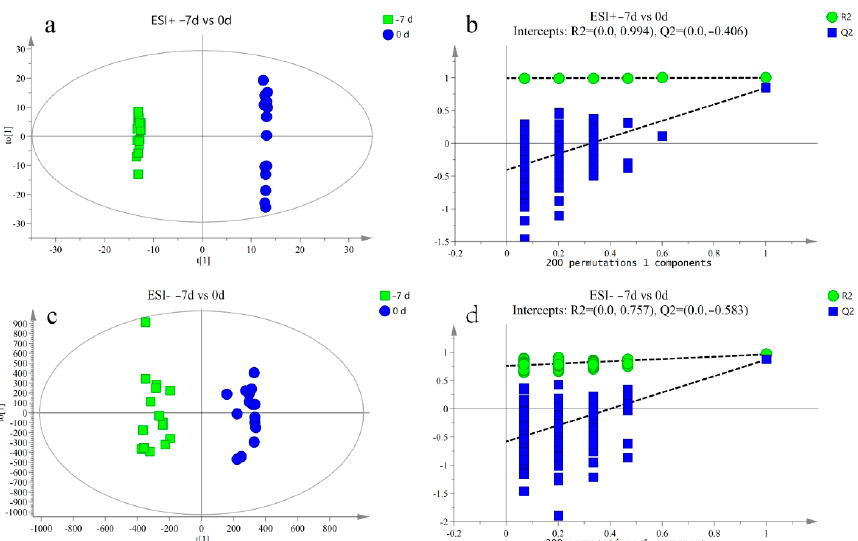
Figure 3. ( a , b ) Orthogonal partial least squares discriminant analysis (OPLS-DA) of scores and per- mutation test plots for the − 7 d and 0 d group samples analyzed in the positive ion mode, respec- tively. ( c , d ) Orthogonal partial least squares discriminant analysis of scores and permutation test plots for the − 7 d and 0 d group samples analyzed in the negative ion mode, respectively. t[1]—first principal component; to [1]—second orthogonal component. The intercept limit of Q 2 , calculated by regression line, is the plot of Q 2 from permutation test in the OPLS-DA model.